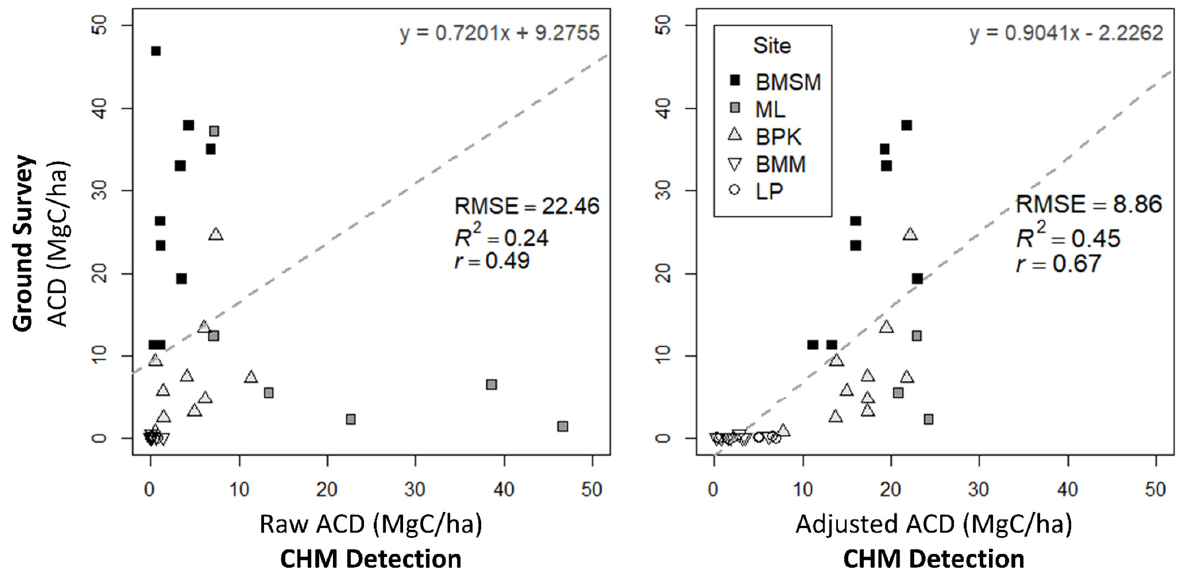
Figure 11. Scatter plots of ACD: ( Left ) ACD from CHM. ( Right ) Adjusted ACD from a multiple regression model, with ACD and stocking density from CHM. ACD = Above-ground carbon density; CHM = Canopy-height model; RMSE = Root mean square error; r = Pearson’s correlation coef- ficient.